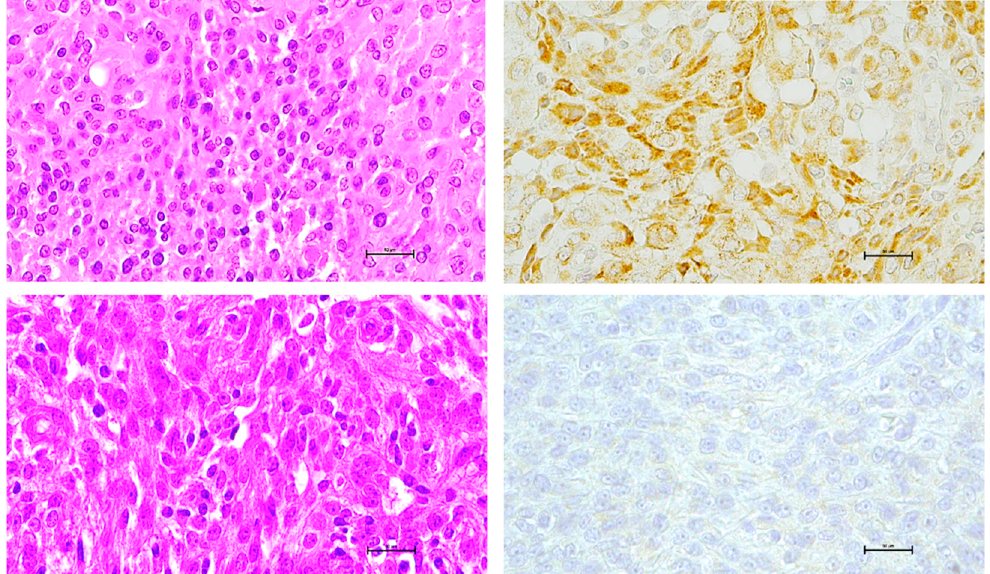
Figure 1. Immunohistochemical evaluation of SOX2. Upper row. WHO grade 3 meningioma, hematoxylin and eosin (H&E) staining ( left) and strong (3+) SOX2 IHC positivity ( right) . Lower row. WHO grade 1 meningioma, H&E staining (left) and SOX2 IHC negativity ( right) . Scale bar, 50 μ m.